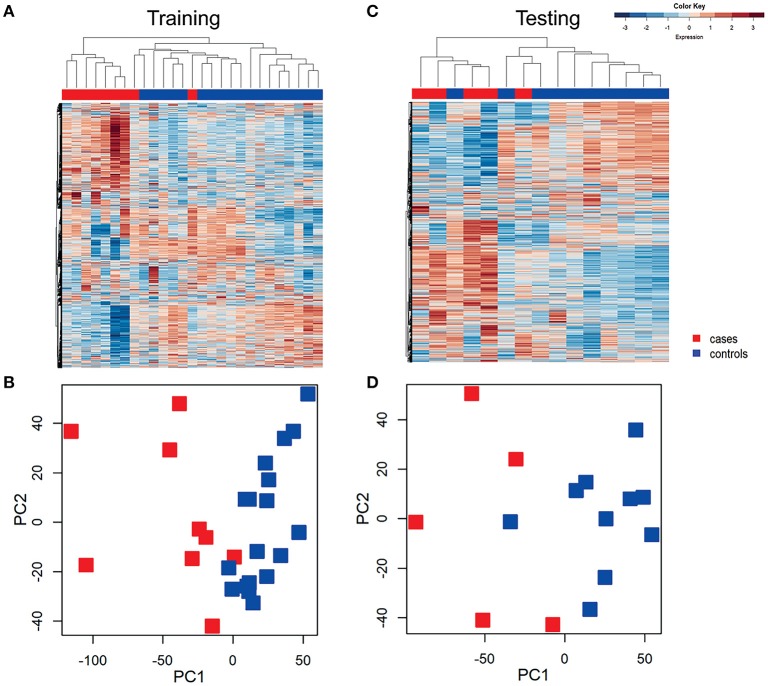
Unsupervised hierarchical clustering and principal component analysis (PCA) revealed distinctive blood mRNA transcriptional profiles separating cases from controls. Unsupervised hierarchical clustering of blood transcriptional profiles of women in training (A) and testing (B) datasets using 4952 transcripts. Samples were ordered by hierarchical clustering (Spearman correlation with average linkage) creating a condition tree, upper horizontal edge of heat map; study groupings (clinical phenotypes) are the colored blocks on the top of each profile. Heat map rows are genes; columns are participants. Principle component analysis of the variance in mRNA expression of the subjects depicted in the heat maps in training (C) and testing (D) datasets, using 4,952 transcripts and the same color scheme with each colored square depicting one subject. The x axis represents the first principal component, PC1, which accounts for the largest variance of mRNA expression, and the y axis, PC2, explains the second largest variance.